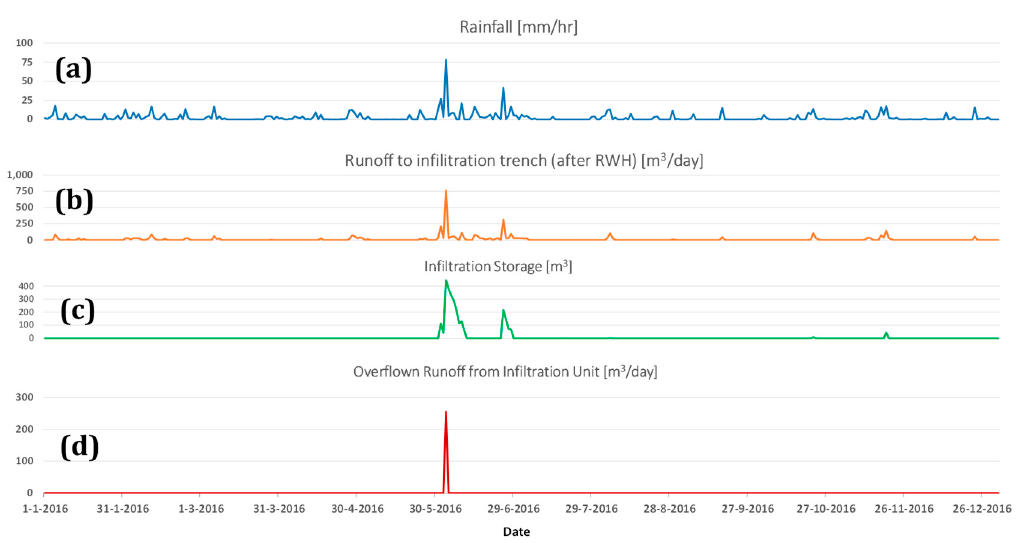
Figure 9. Time-series of the decentralized system DW autonomy for both design options.